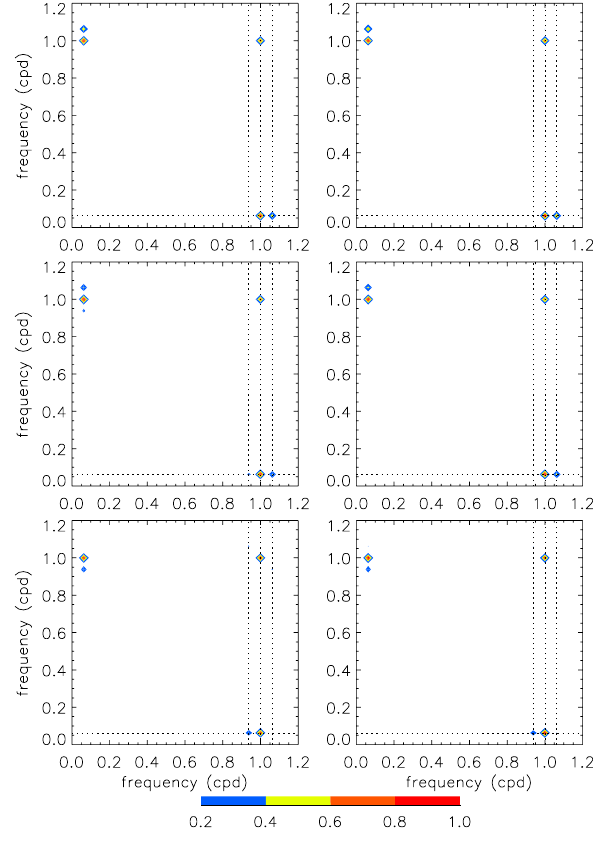
Fig. 6. Normalized bispectrum. The dotted horizontal line repre- sents the 16-day wave, and the dotted vertical lines from left to right represent the 25.6, 24 and 22.59-h waves, respectively. The left col- umn denotes the normalized bispectrum at 90km (bottom), 92km (middle) and 94km (top), and the right column denotes the normal- ized bispectrum at 91km (bottom), 93km (middle) and 95km (top),